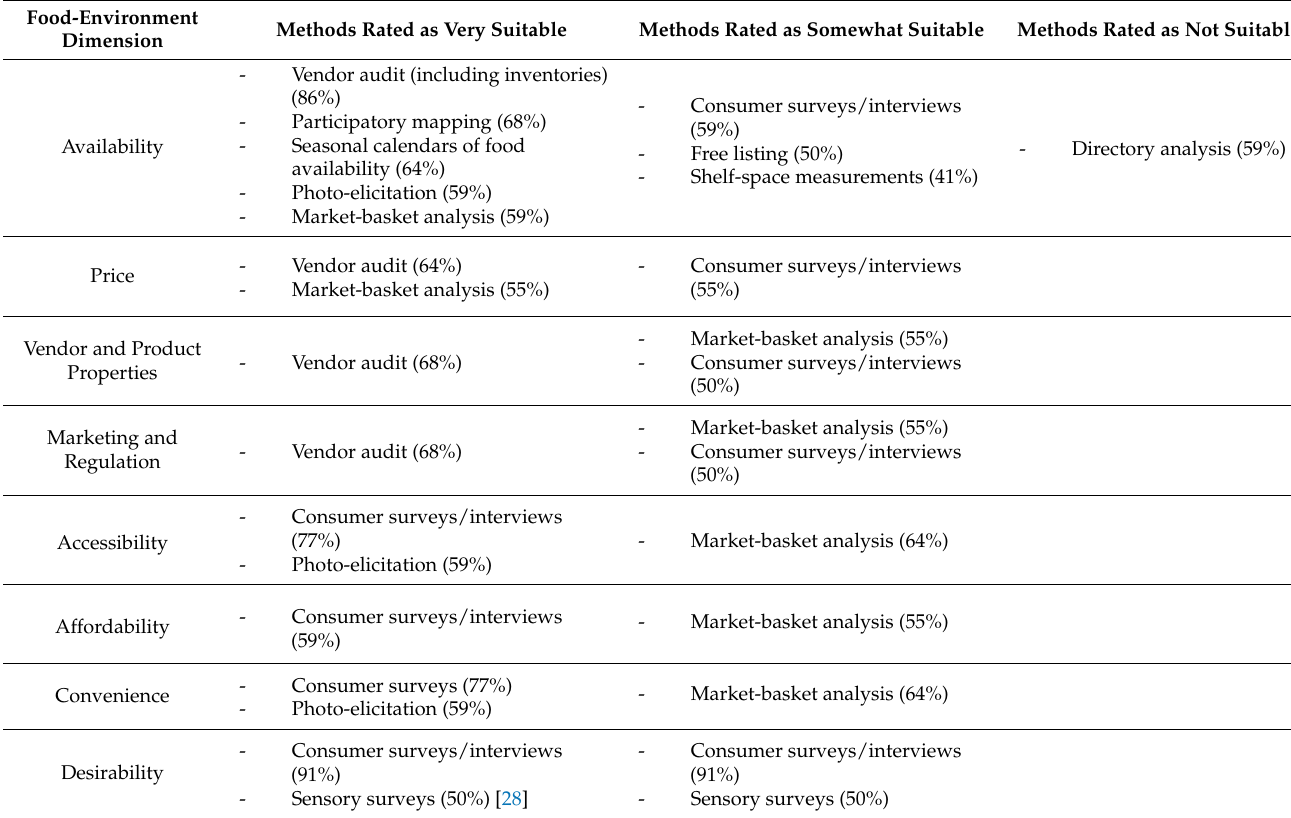
Table 1. Suitability of Methods Based on Expert Ratings a